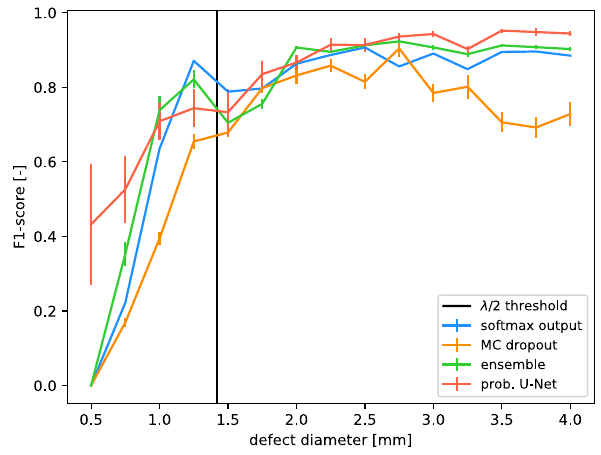
Fig. 14 Dependency of the F1-score from the defect size for com- plicated defect shapes